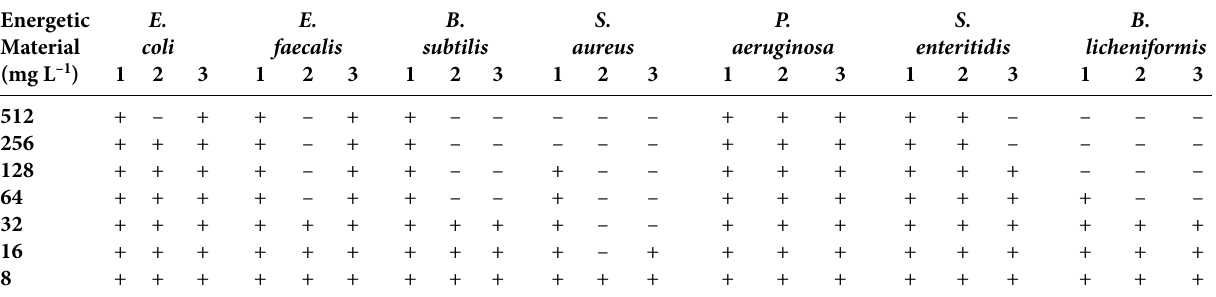
Table 9. The antimicrobial tests results of the energetic materials toward seven different bacteria.